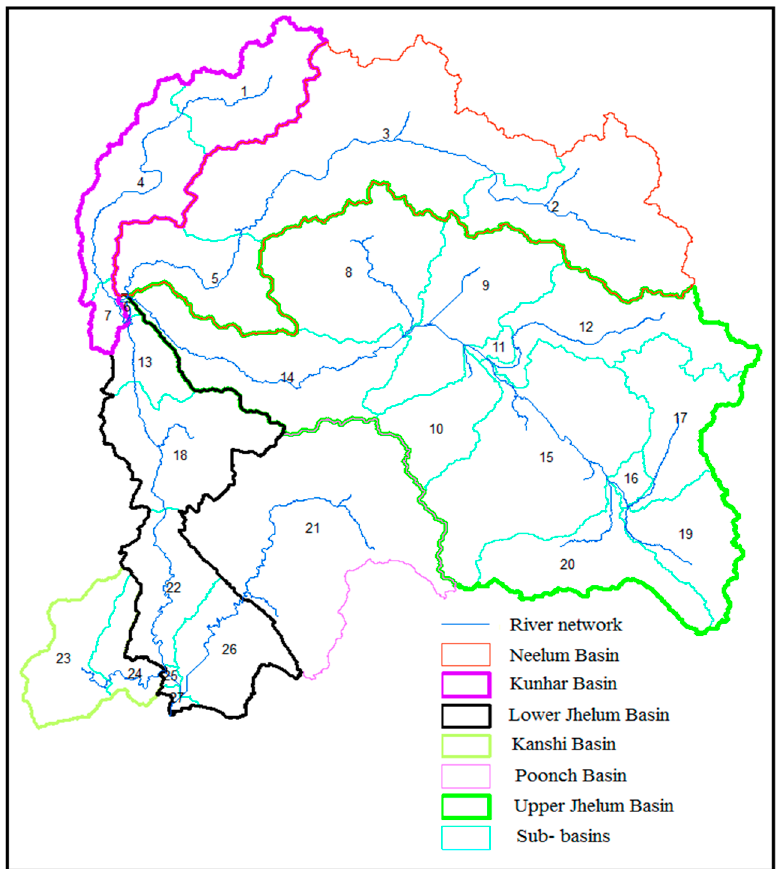
Figure 3. Sub-basins generated during delineation.